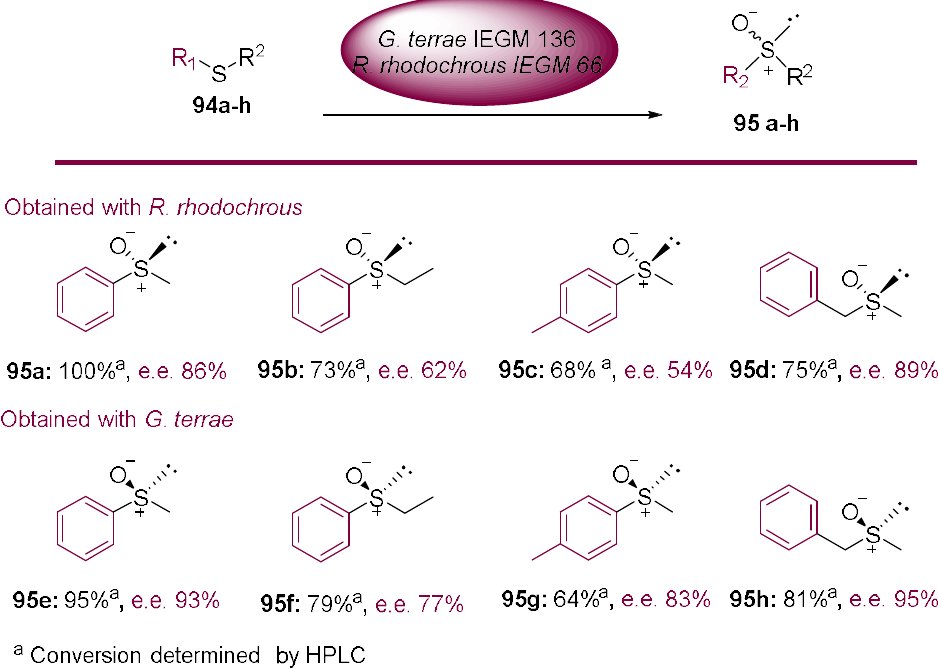
Scheme 27. Oxidation of sulfides by R. r hodochrous and G. terrae.